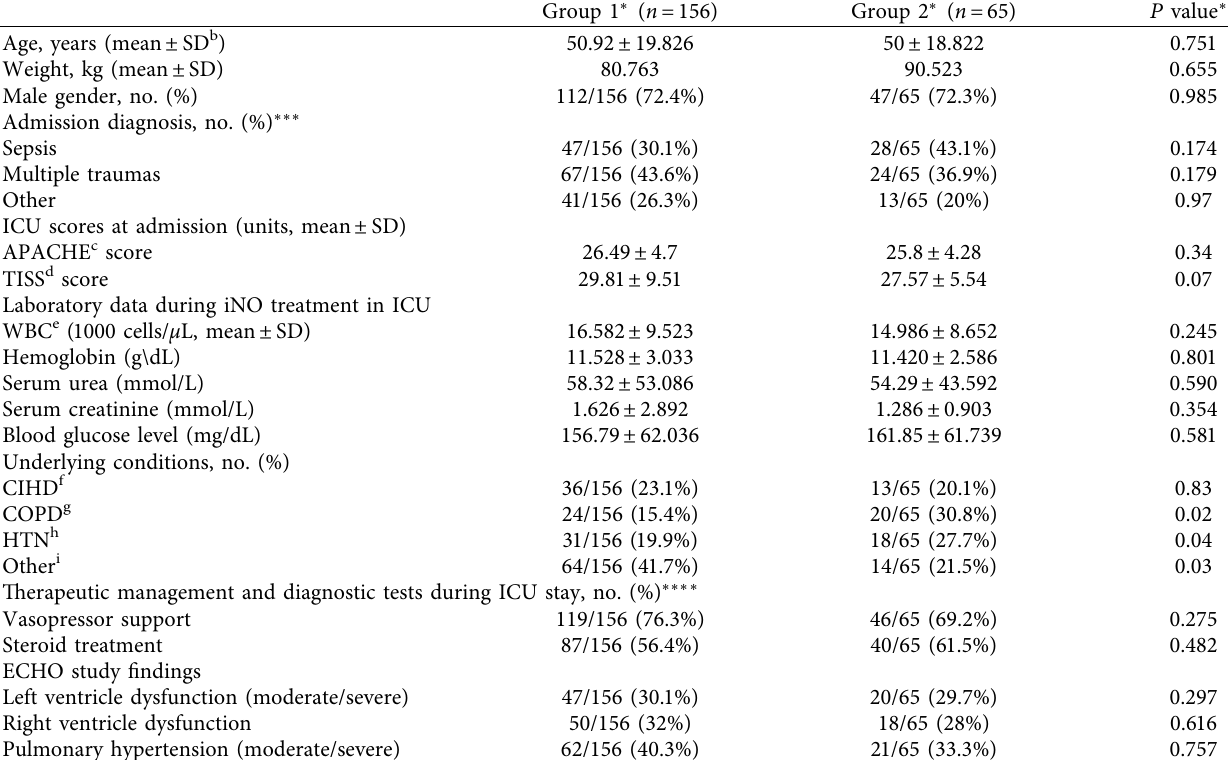
Table 1: The demographics, underlying conditions, admission diagnoses, laboratory data, and therapeutic management during the ICU stay.